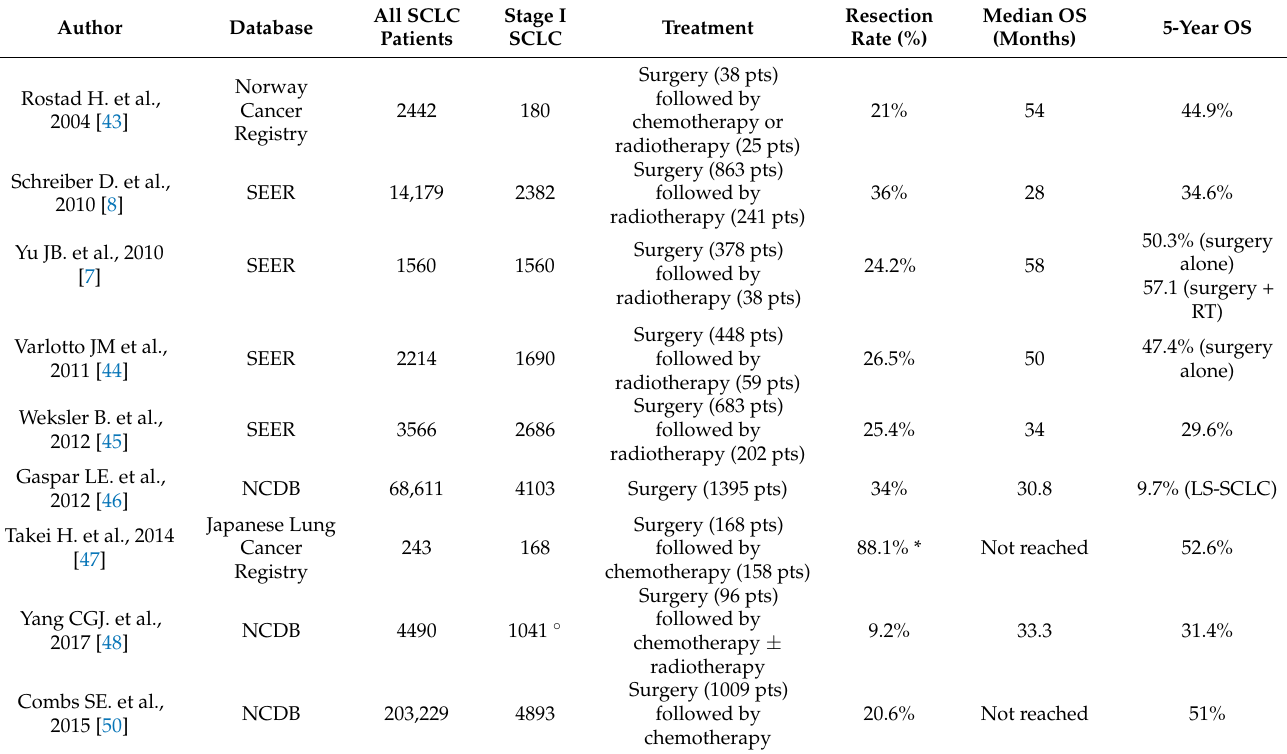
Table 4. Cancer database